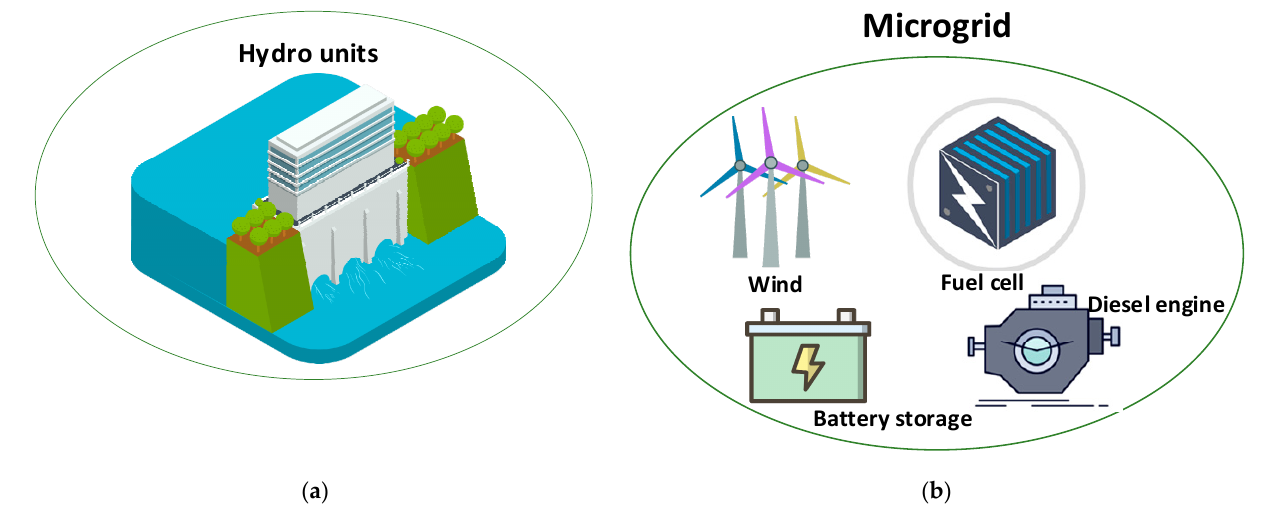
Figure 3. GENCOs ( a ) Hydro units used in GENCO-1 and GENCO-3, ( b ) Microgrid used in GENCO-2 and GENCO-4. Table 1. Generation companies in the modeled deregulated power system.